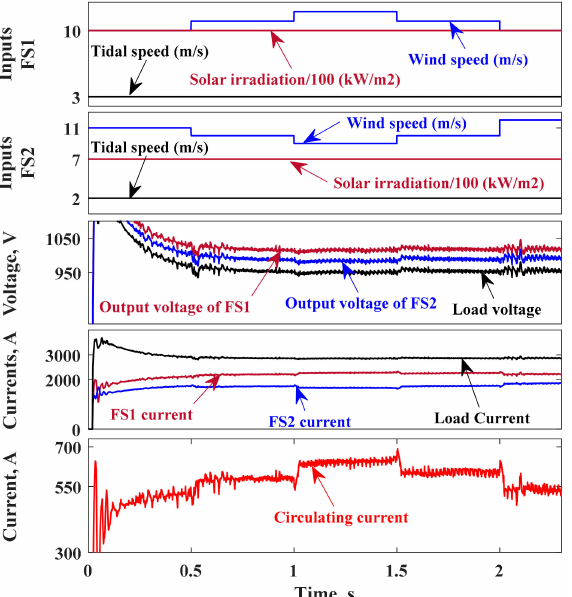
Figure 20. Simulation results of two floating energy units connected in parallel with a single energy storage